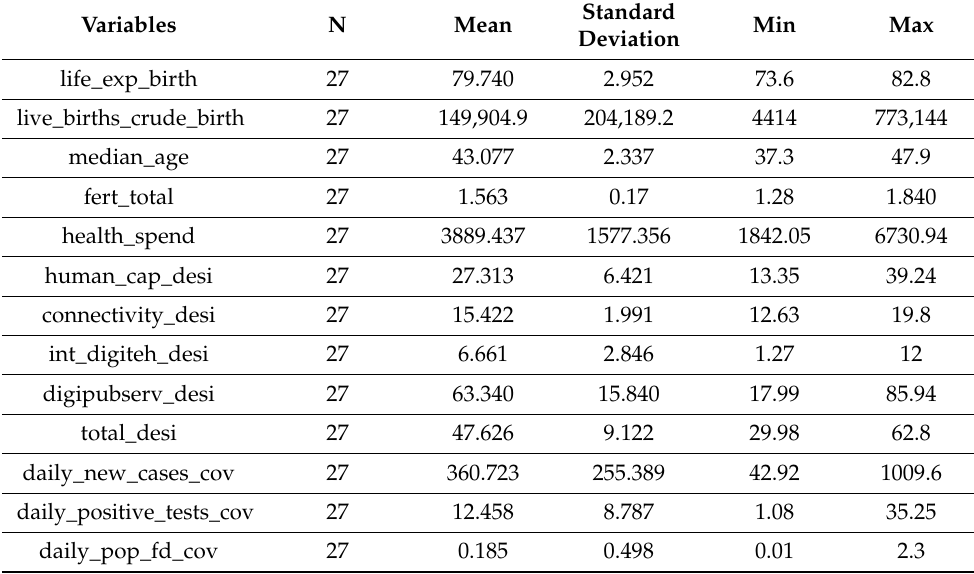
Table 2. Descriptive statistics, EU-27,